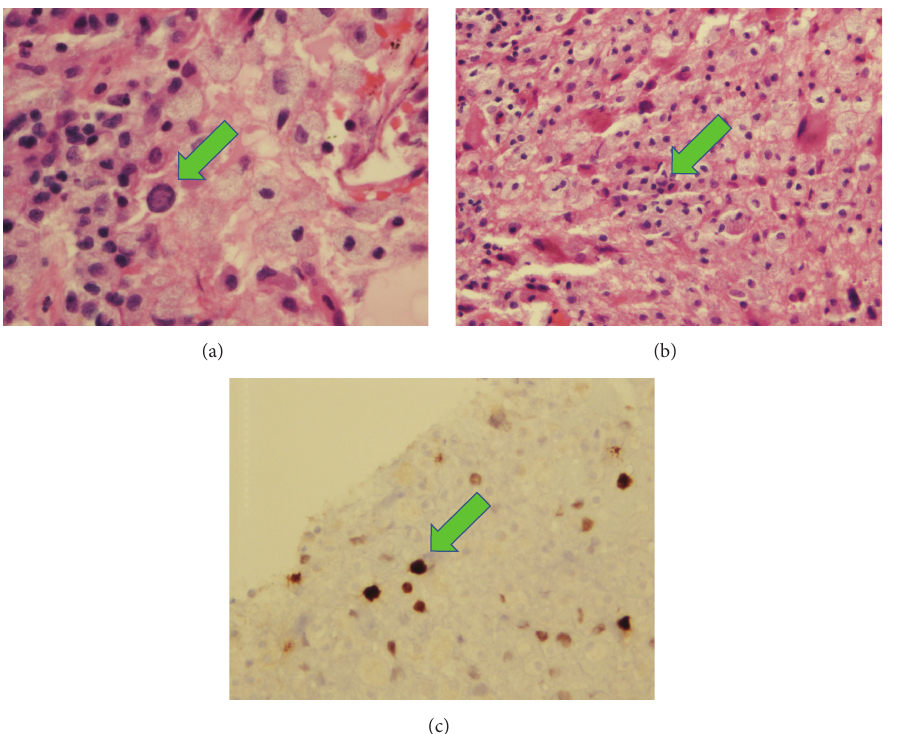
Figure 5: Frontal lobe biopsy of the brain showing chromatic margination in oligodendrocytes (a), perivascular mixed chronic inflammation (b), and SV40 antigen positivity (c) consistent with JC virus infection. The aforementioned histological findings are demarcated by green